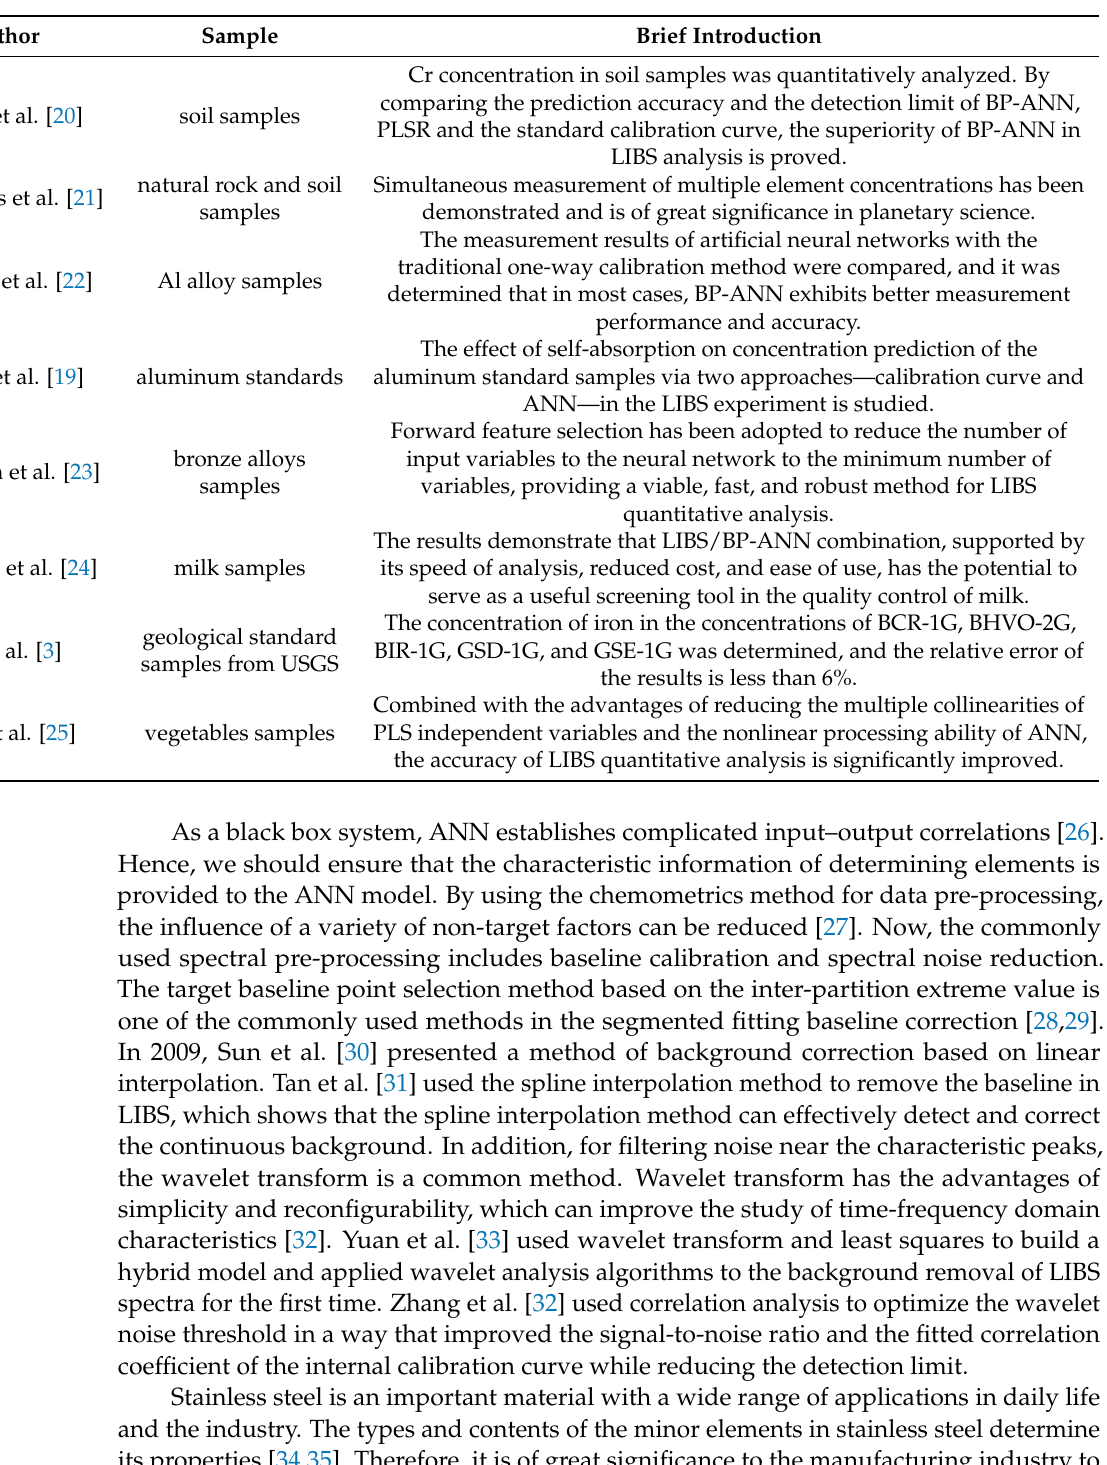
Table 1. Examples of quantitative analysis based on BP-ANN in LIBS